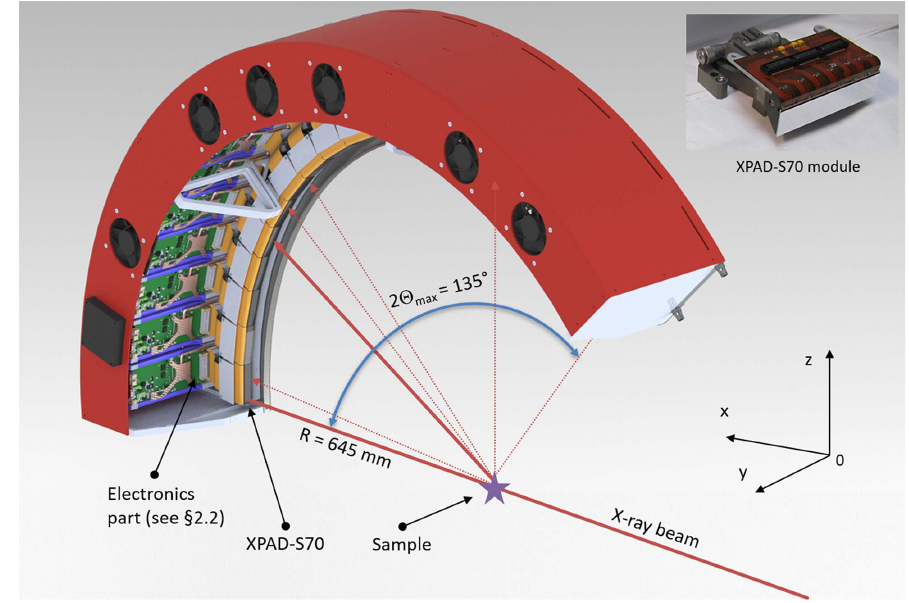
Figure 1 Schematics of the CirPAD, showing (top-right inset) a photograph of an XPAD-S70 module assembly with a silicon